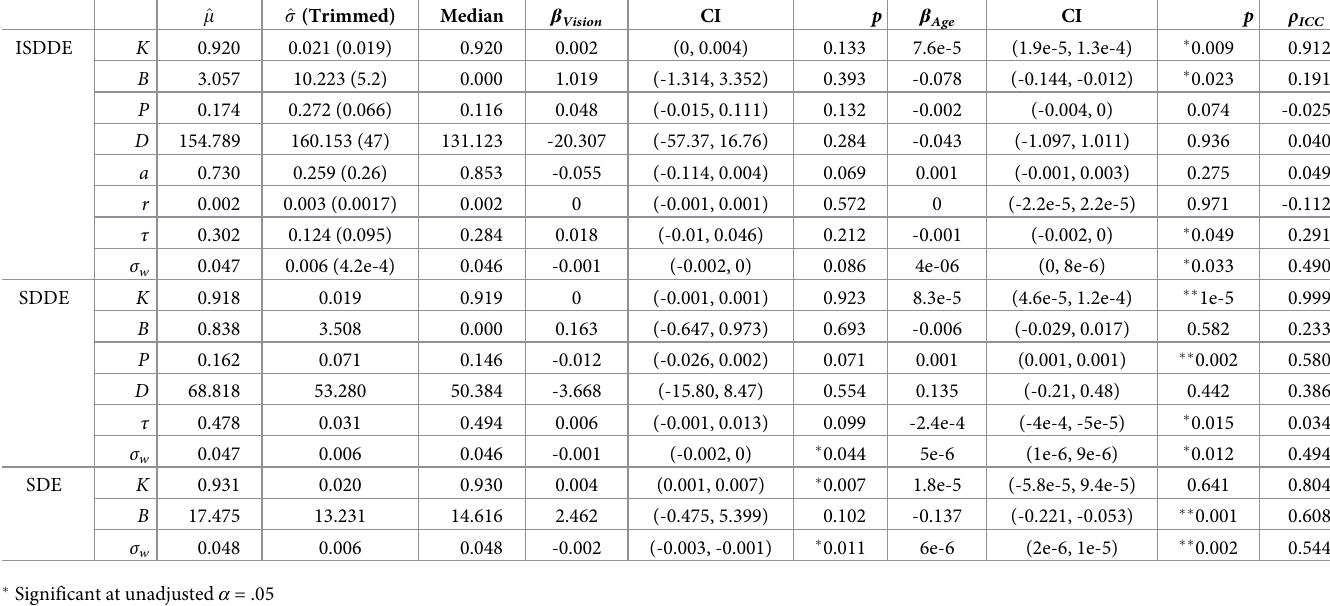
Table 7. Summary statistics, effects of age and vision accounting for height and mass, and person-level intraclass correlations of parameter estimates under each model. Bonferroni adjusted α = .0029. ^ m ^ s (Trimmed)